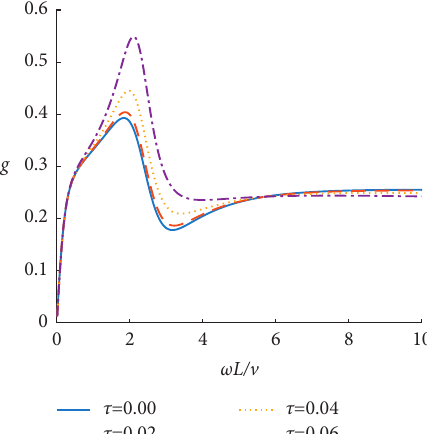
Figure 4: Influence of the nonlocal coefficient on the equivalent couple amplification factor at the midpoint of the